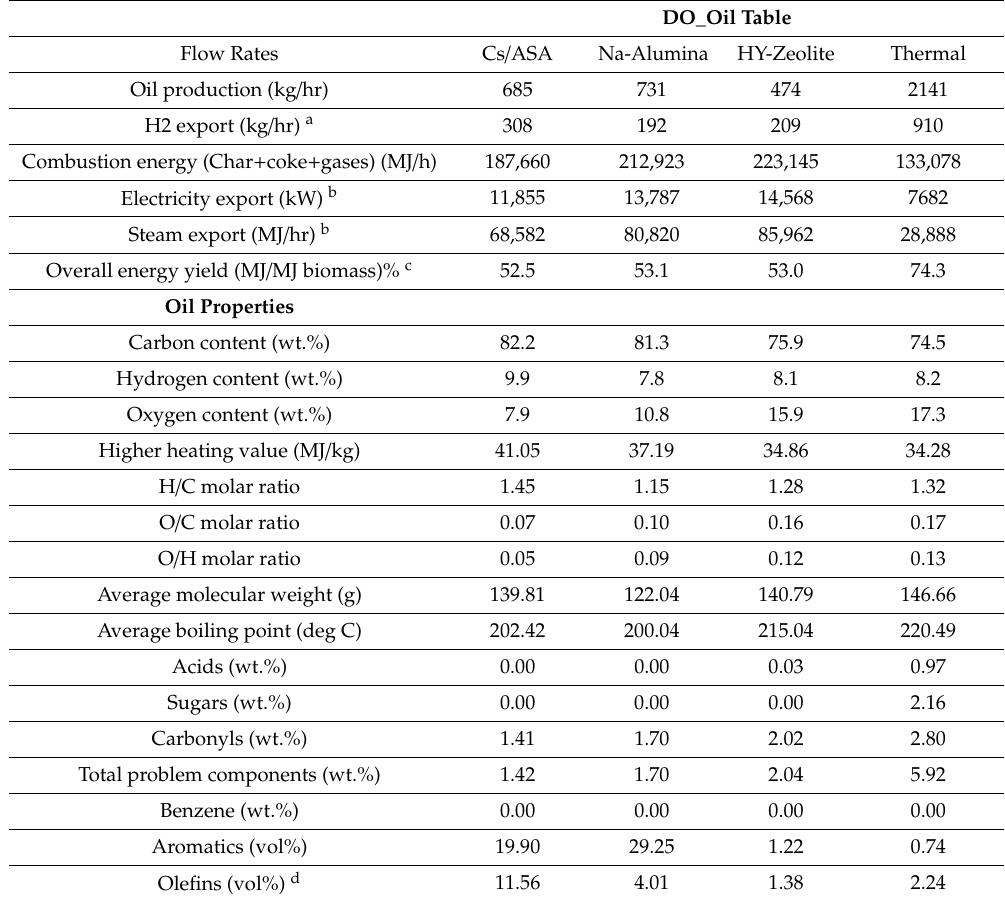
Table 8. Oil properties and process results for the DO_oil scenario.